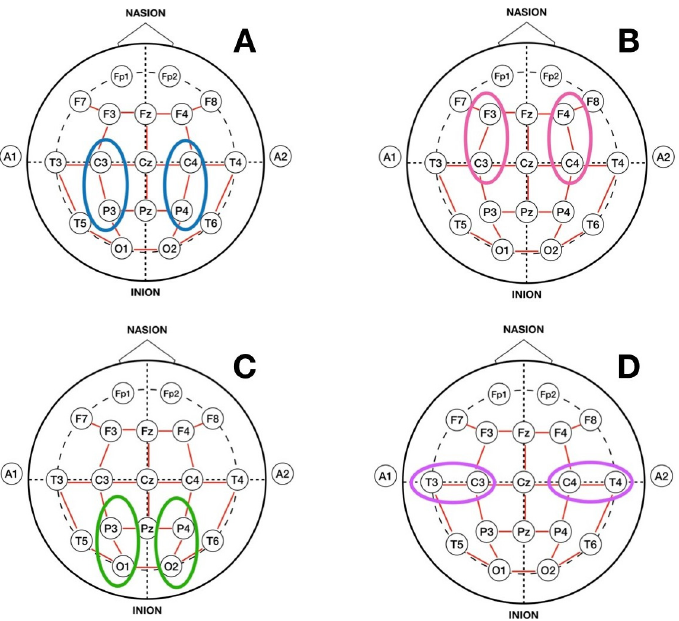
Figure 2. Homotopic pair connectivity was examined in four mirror regions in the left and right hemispheres including ( A ) centro-parietal (C3-P3 and C4-P4), ( B ) fronto-central area (F3-C3 and F4- C4), ( C ) parieto-occipital (P3-O1 and P4-O2) and ( D ) centro-temporal (C3-T3 and C4-T4) connec- tions.